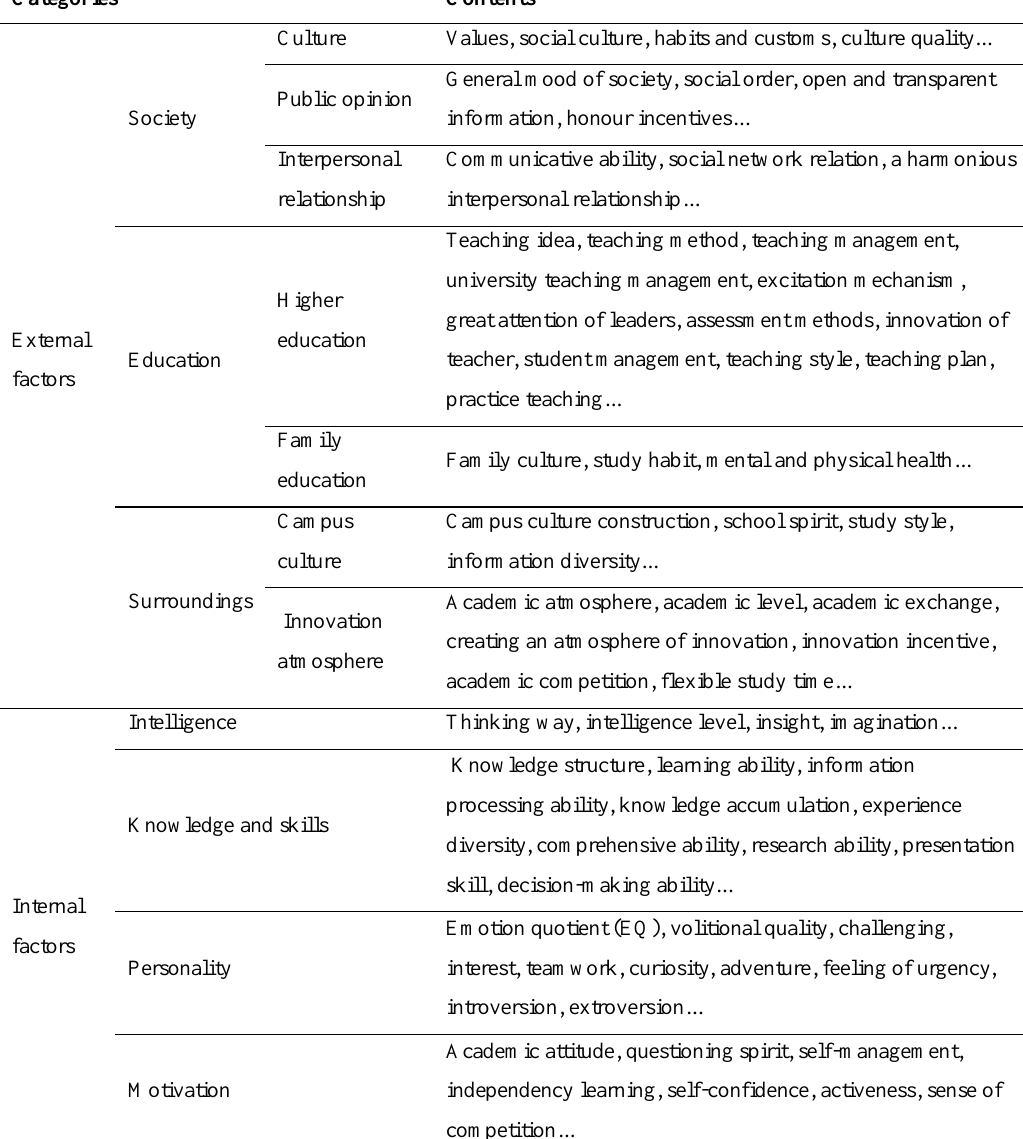
Table 1 Important influencing factors of creativity development of applied